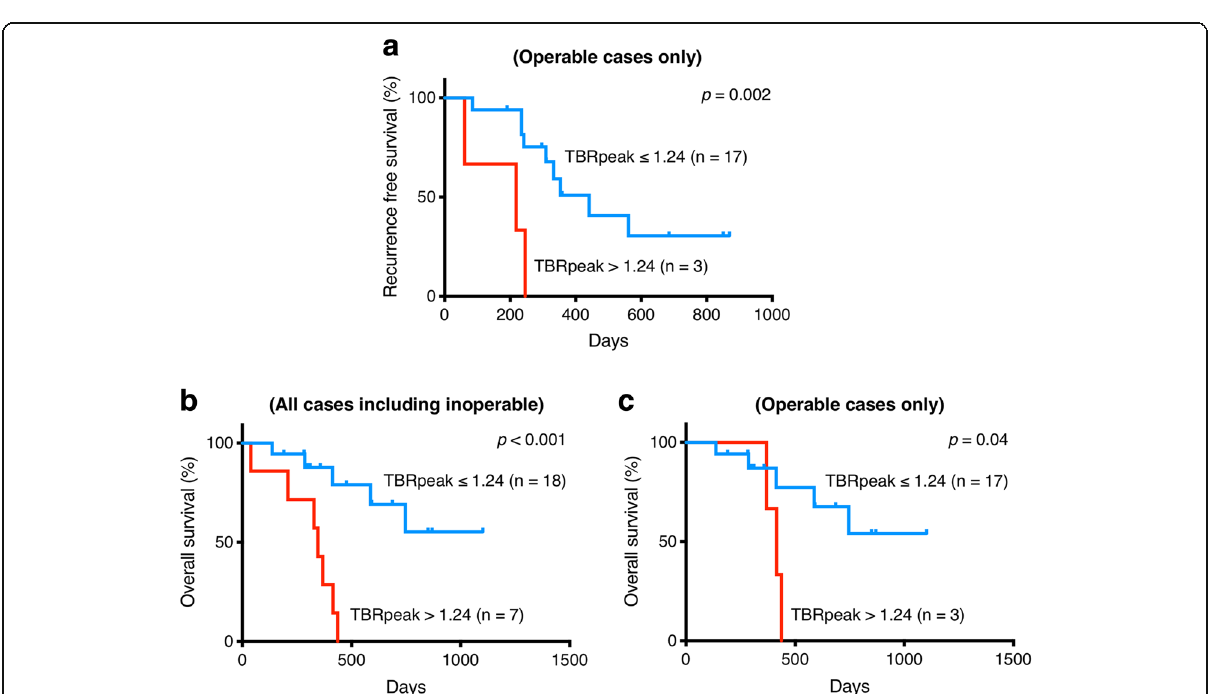
Fig. 3 Kaplan-Meyer survival curves about the recurrence-free survival rate ( a ) and the overall survival rates of low-TBRpeak (blue lines) and high- TBRpeak (red lines). For the overall survival, curves of all cases including inoperable ( b ) and of only operable cases ( c ) are shown. TBR tumor blood